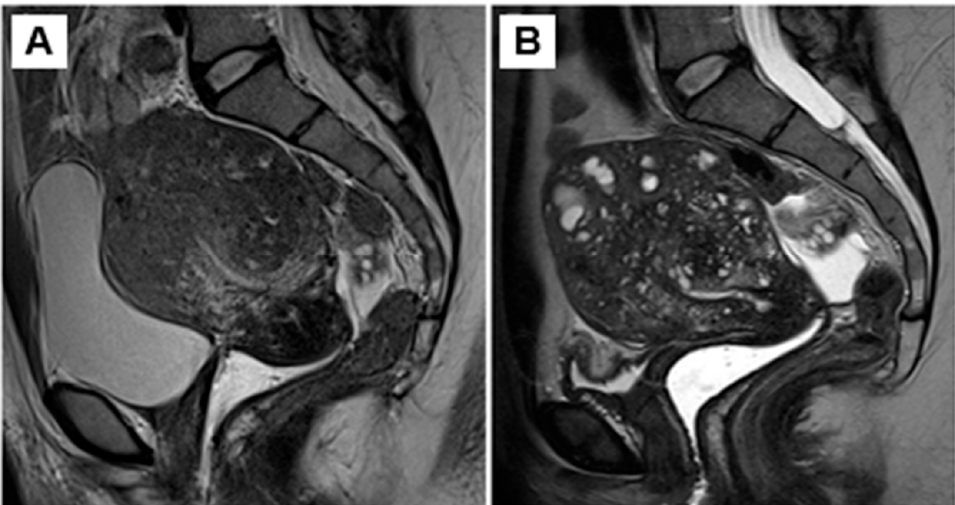
Figure 1. ( A ) MRI showing an enlarged uterus with diffuse and disseminated adenomyosis. ( B ) Worsening of MRI features after therapy with UPA. Numerous spots typical of adenomyosis are visible: asymmetric heterogeneous myometrium with multiple myometrial cysts, related to dilated islets of ectopic endometrium.